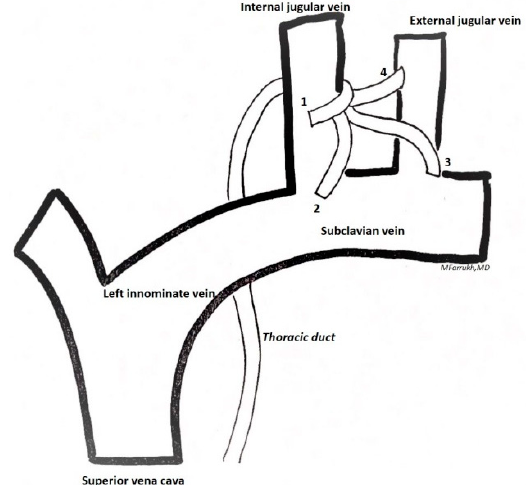
Figure 2. Variations in confluence of the thoracic duct in the venous system: 1—internal jugular vein; 2—jugulovenous angle; 3—subclavian vein; 4—external jugular vein/other.